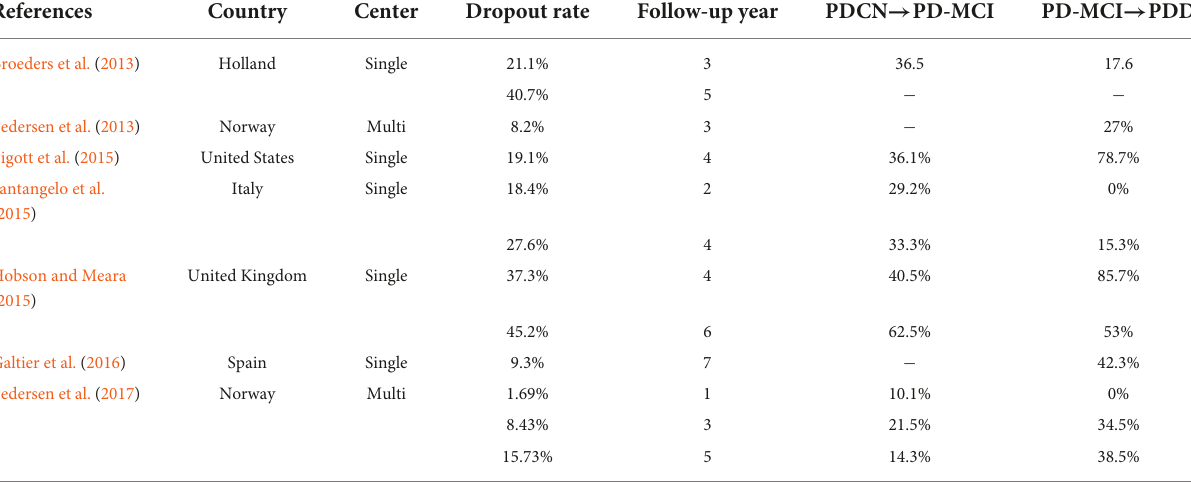
TABLE 1 The longitudinal studies explore the trajectory of cognitive function in patients with